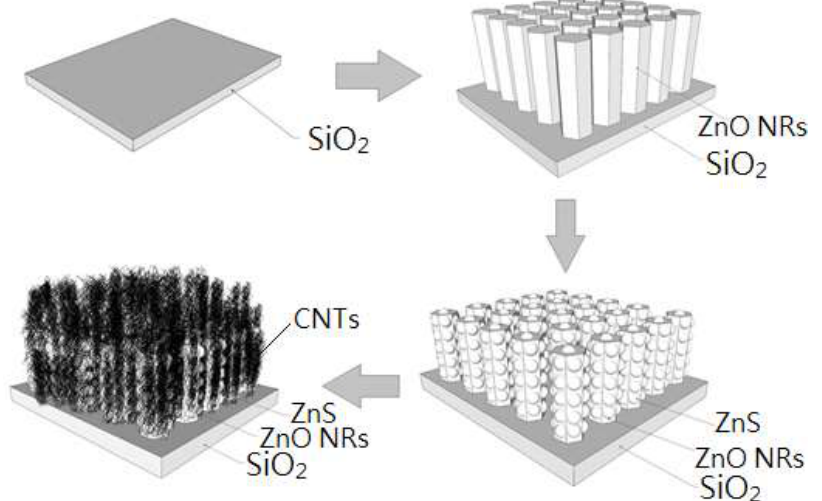
Figure 1. Schematic diagram of fabrication processes of ZnO / ZnS core–shell nanostructure / carbon nanotubes (CNTs) on SiO 2 substrate.